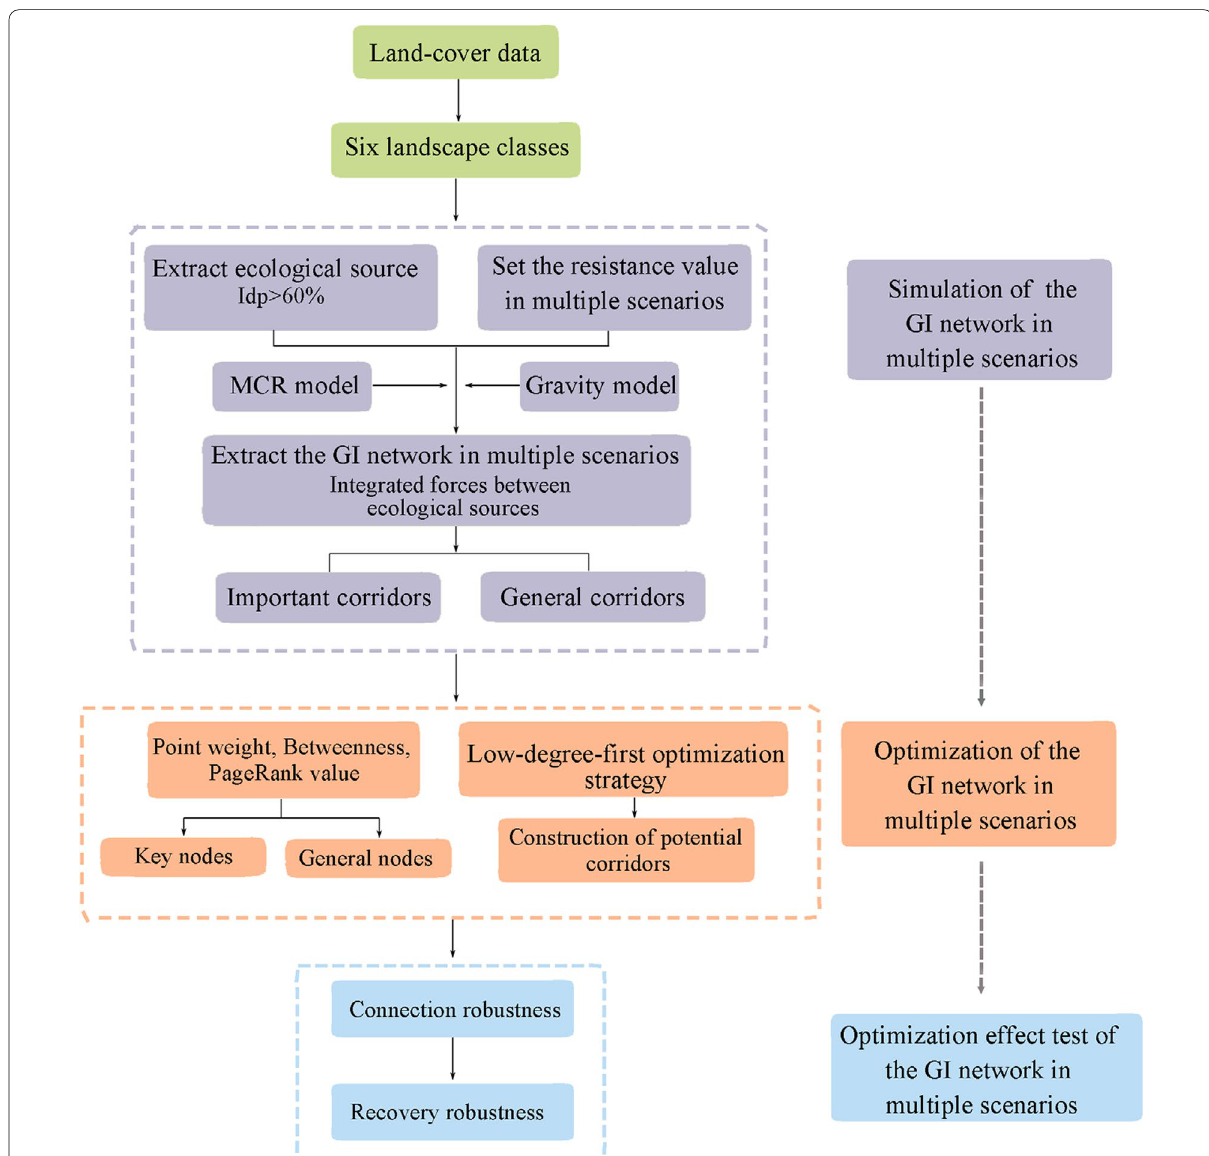
Fig. 1 Flowchart of the present research. GI green infrastructure , MCR minimal cumulative resistance, Idp importance values of the